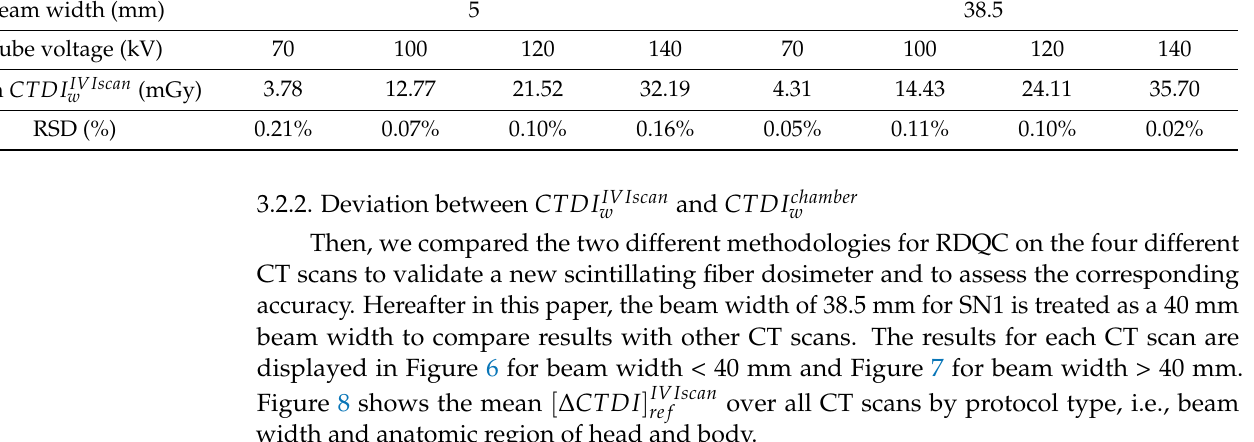
, at 120 kV for ref